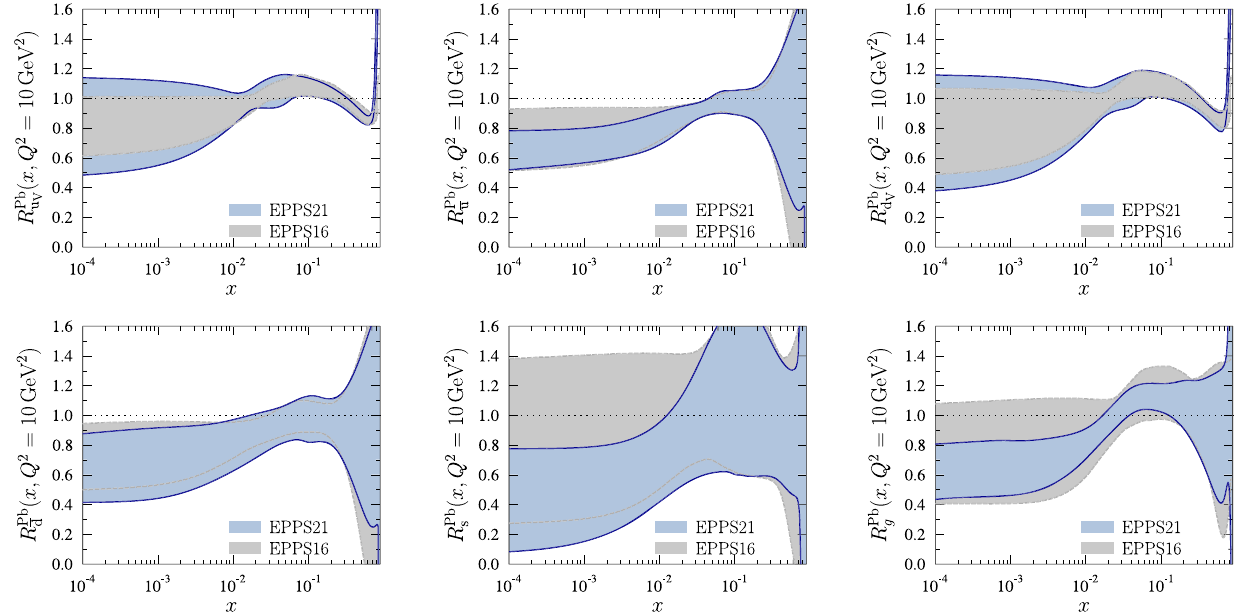
Fig. 10 Comparison between the EPPS21 (blue) and the EPPS16 (gray) [1] average-nucleon nuclear modifications at Q 2 = 10GeV 2 . The EPPS21 uncertainties include the free-proton uncertainties but the EPPS16 error bands only include the nuclear